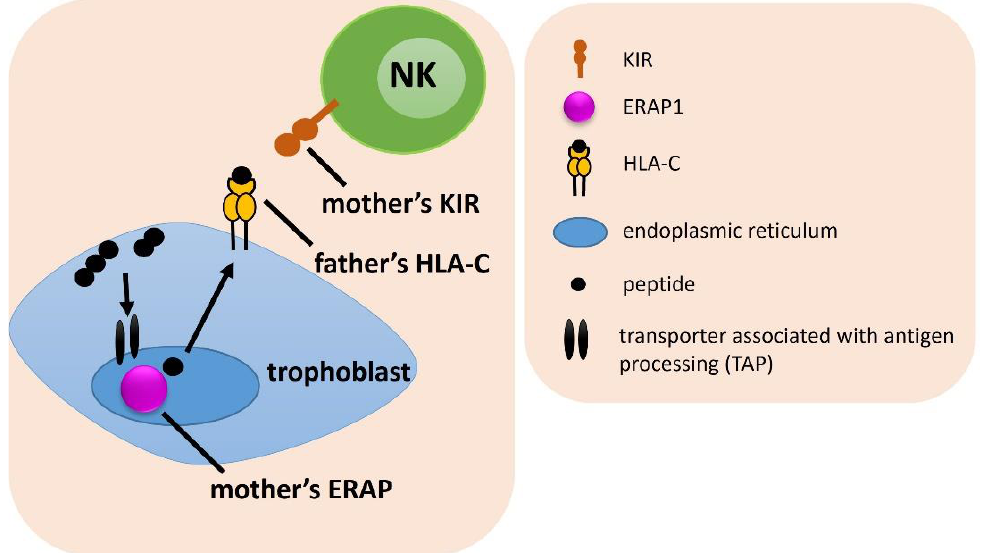
Figure 3 . The influence of female KIR/ERAP and male HLA-C on embryo implantation. The arrows indicate the successive stages of the formation of antigenic peptides.